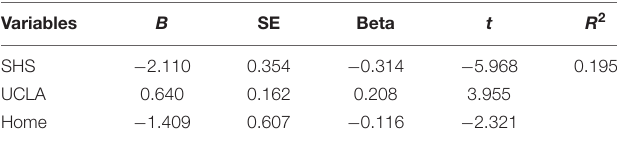
TABLE 6 | Regression model: Mental Health (GHQ) as dependent variable.